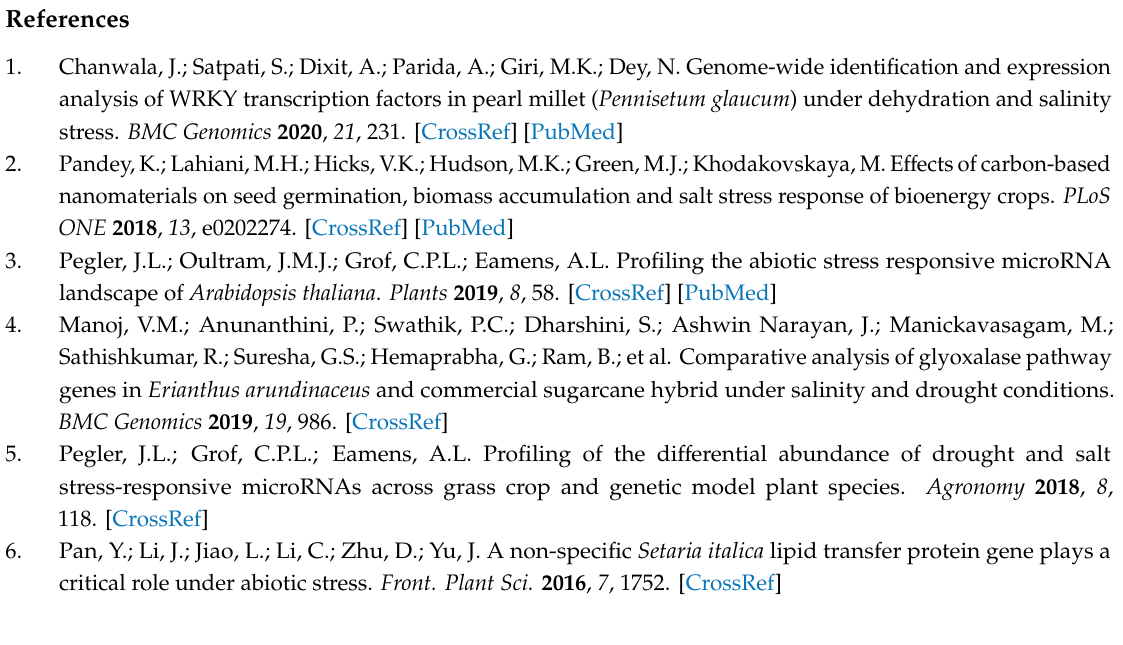
Table S1: Sequences of DNA oligonucleotides used in this study. Table S2: microRNA read number for each detected S. viridis microRNA in A10 and ME034V